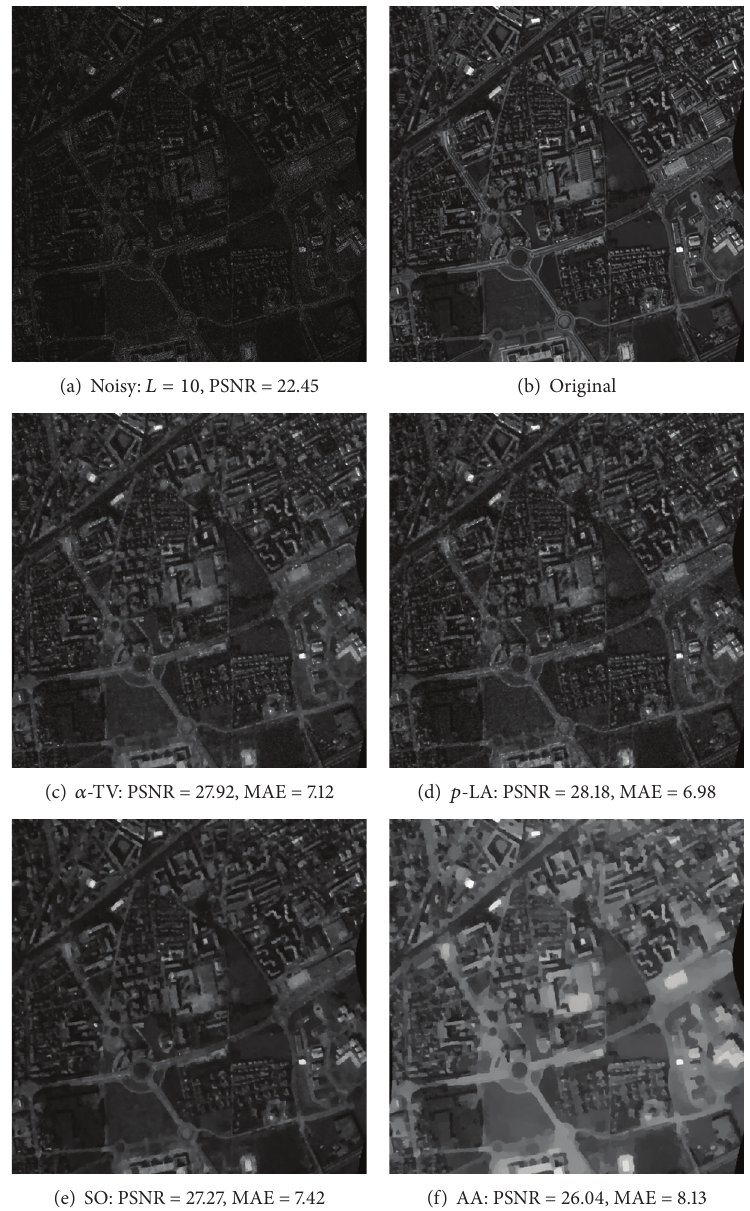
Figure 7: Aerial image ( 512 × 512 ). (a) Noisy image corrupted by speckle noise for 𝐿 = 10 in (8). (b) Original image. (c) Our algorithm by = 1.4 . (e) SO algorithm, 𝜆 = 1.2 , 𝛼 = 0.25 . (f) AA algorithm, 𝜆 = 130 𝛼 -TV, 𝜎 = 2 , 𝑘 = 0.015 , and 𝜏 = 0.05 . (d) Our algorithm by 𝑝 -LA, 𝑝 𝑈